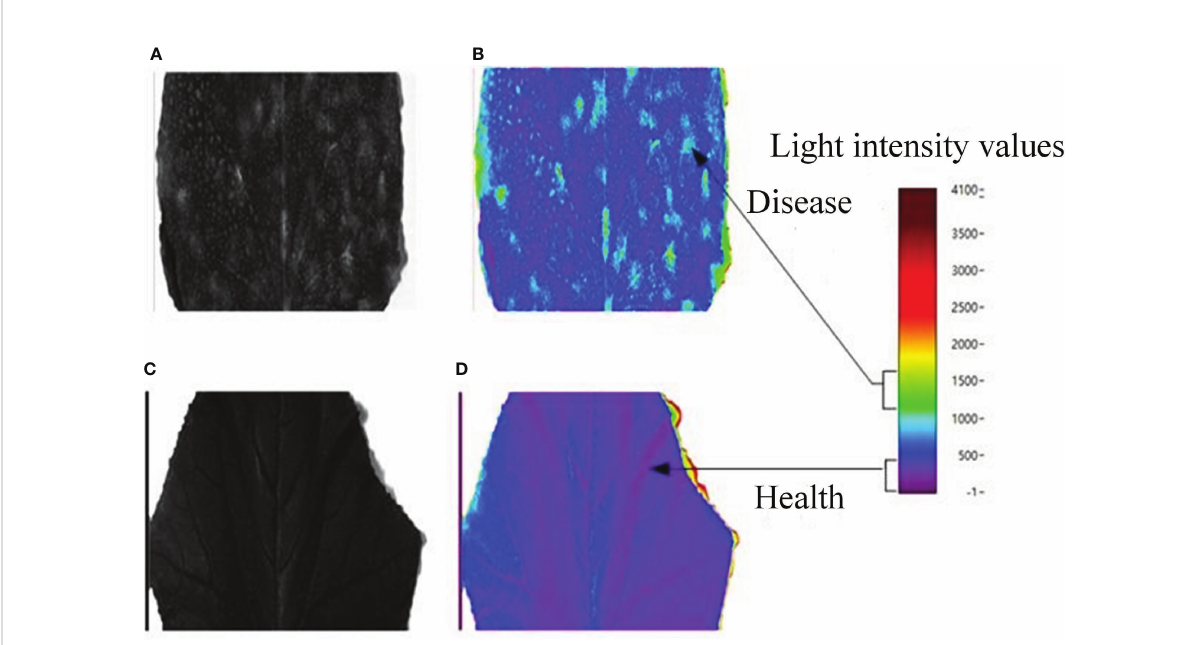
FIGURE 8 Characteristic images of visible light at 669.31nm: (A) Cucumber powdery mildew; pseudo-color images of (B) cucumber powdery mildew and (D) healthy cucumber samples; (C) Healthy samples of cucumbers.